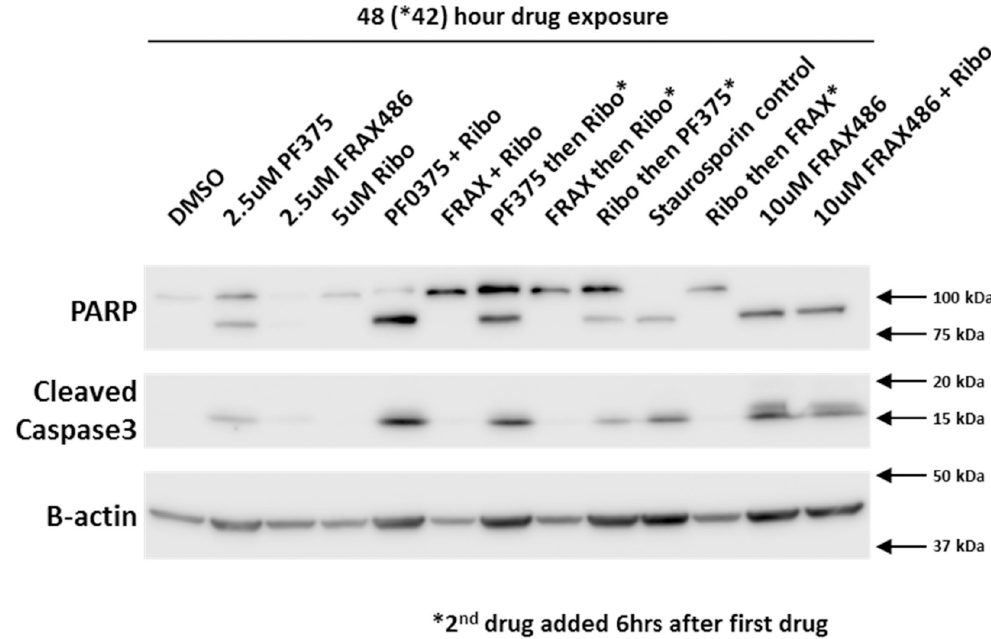
Fig 3. Cleavage of Caspase 3 and PARP following treatment with PF03758309 and its combinations. Apoptosis was determined by immunoblot detection of cleaved Caspase 3 and PARP measured in H322 after 48 hours treatment with the indicated drugs. Drug concentrations were the same as in Fig 2 with the addition of 10 μ M FRAX486. https://doi.org/10.1371/journal.pone.0252927.g003 15.7% for PF03758309 alone to 27.7% in combination with Ribociclib, while apoptosis with FRAX486 treatment was low and did not change between drug alone or in combination (3.12% and 3.37% respectively). For H157 cells (S6 Fig) a similar trend was observed, but over- all apoptosis was significantly lower (PF03758309 alone 3.7% and in combination with Riboci- clib 6.0%). Synergy and apoptosis are marked by the absence of autophagy—